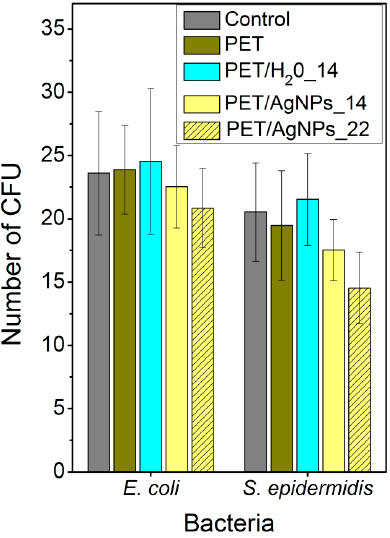
Figure 10. Antibacterial tests performed on pristine PET (PET), underwater laser-treated PET without embedded AgNPs at laser fluence 14 mJ cm − 2 (PET/H 2 O_14), and AgNP-immobilized PET at fluencies of 14 and 22 mJ cm − 2 . Tests were evaluated on E. coli and S. epidermidis and antibacterial efficacy was measured by number of colony-forming units (CFU). Control bar represents CFU of bacteria in pure physiological solution. Table 2. Concentrations of silver Ag3d, carbon C1s, oxygen O1s, and nitrogen N1s (in at. %) in pristine and AgNP-immobilized polymers, derived from XPS analysis.